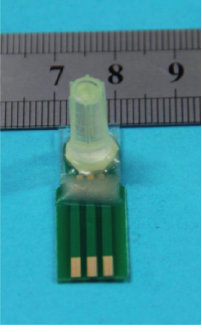
Figure 3. The photo of packaged dissolved oxygen (DO)